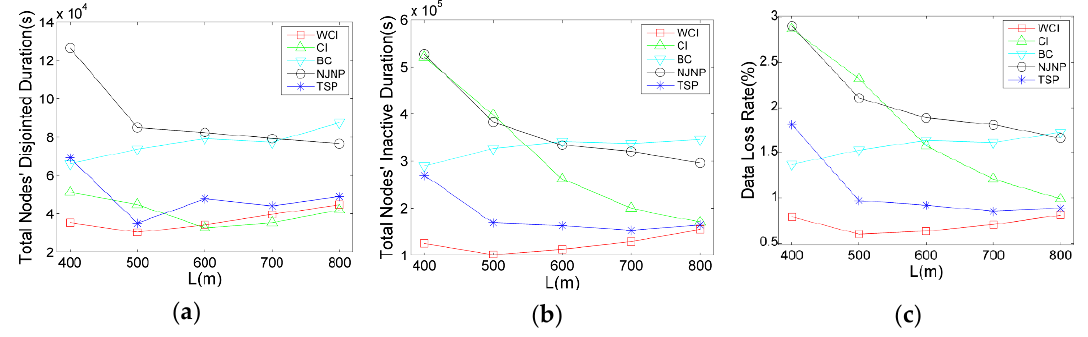
Figure 6. Impact of L on the charging scheduling algorithms: ( a ) Total nodes’ disjointed time; ( b ) Total nodes’ inactive time ; ( c ) Network’s data loss rate .